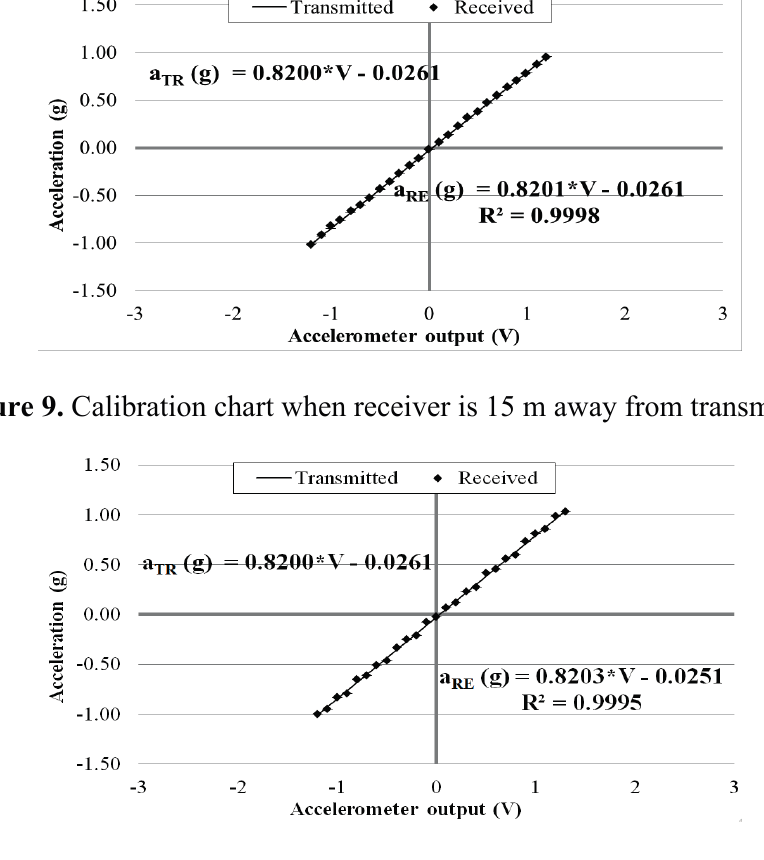
Figure 10. Calibration chart when receiver is 30 m away from